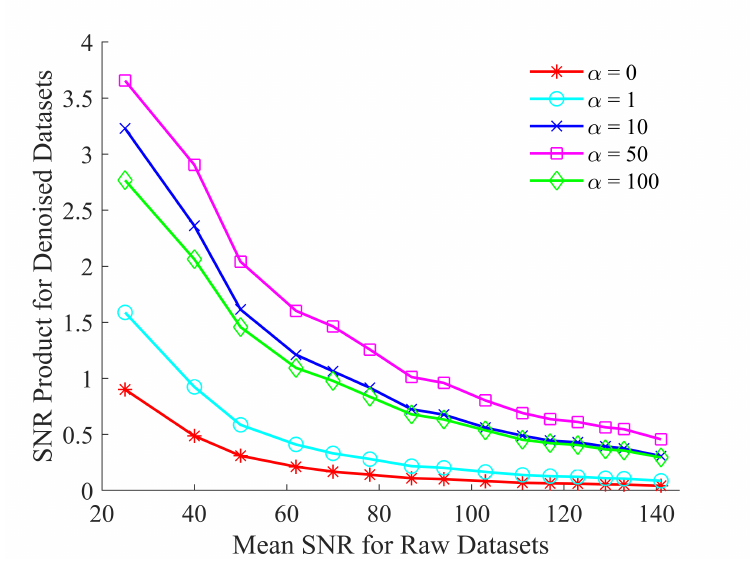
Figure 3. Optimizing the SNR product of CNN denoised spectra by evaluating the custom loss function, defined in Equation (5), for α =